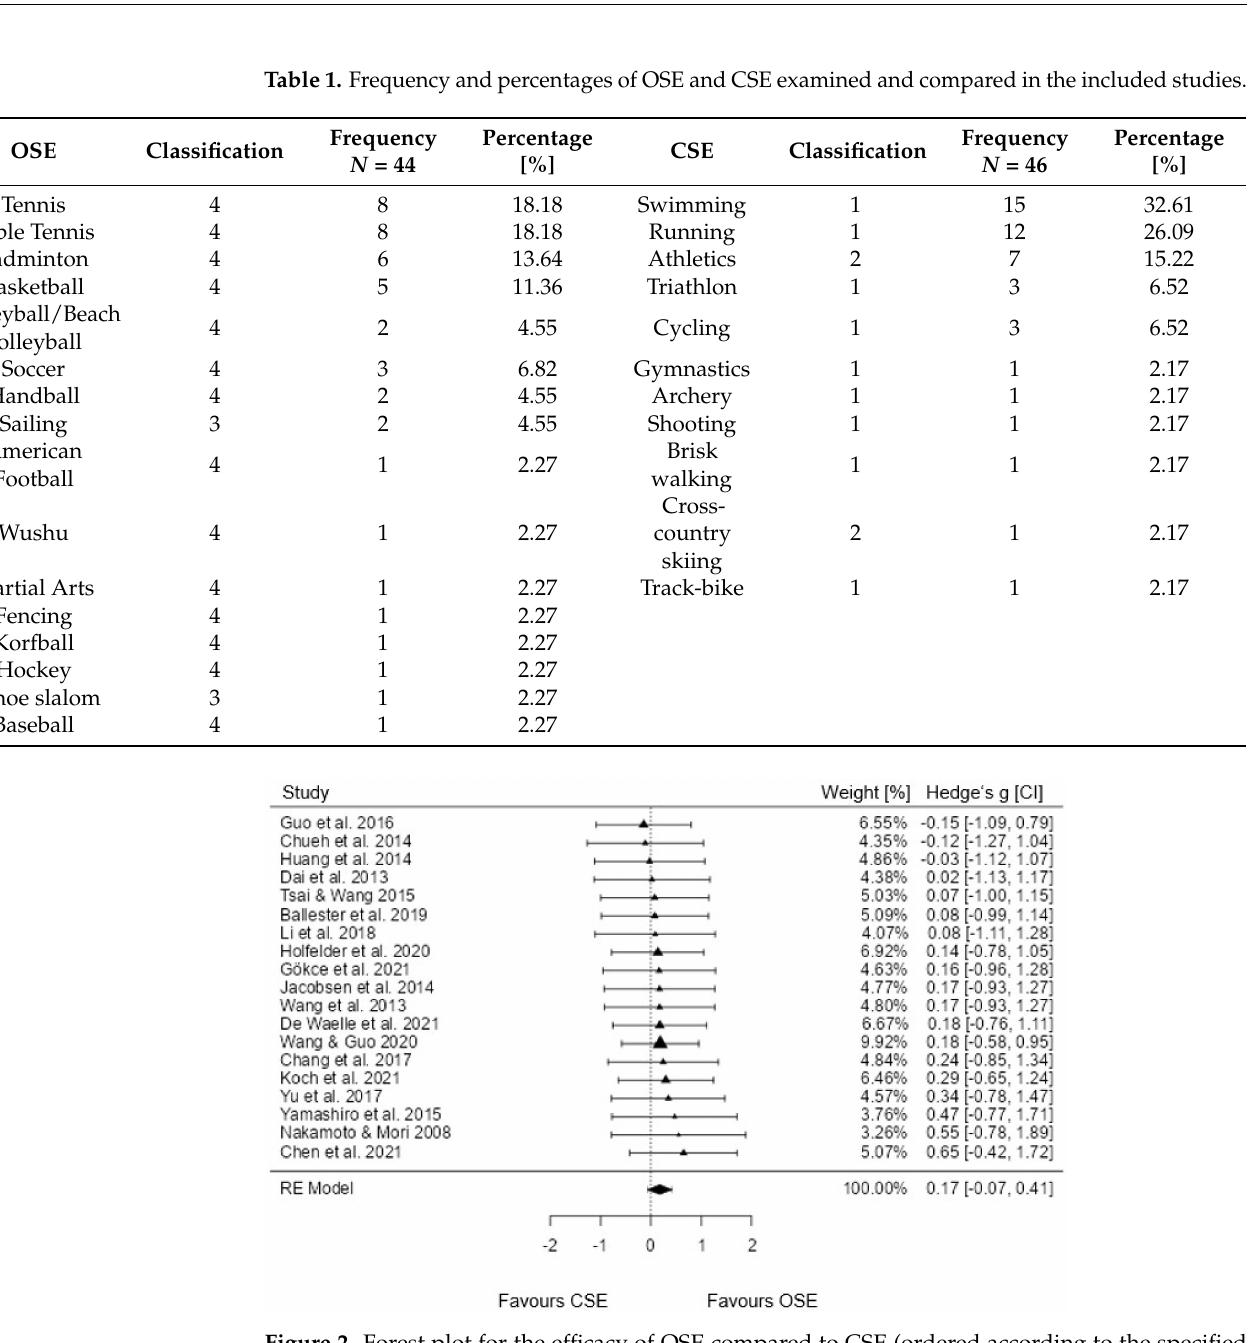
Figure 2. Forest plot for the efficacy of OSE compared to CSE (ordered according to the specified effect size); RE = random effect model [8,25–27,30,37–40,42,43,50–57]. Calendar age was not a moderator in the analysis (mixed model effect: − 0.002; p = 0.686; 95% CI [ − 0.012, 0.008]; SE = 0.005). Study quality was also not a significant mod- erator of the meta-analysis (mixed model effect: − 0.037; p = 0.818; 95% CI [ − 0.356, 0.282]; SE =